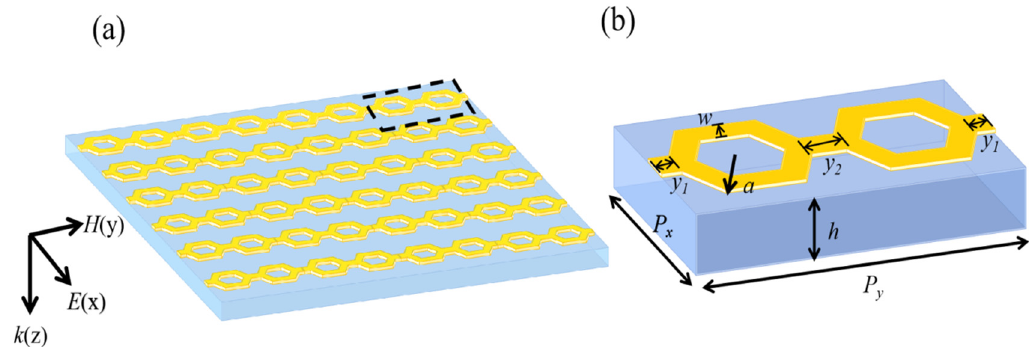
Figure 1. Schematic diagram of cascade hexagonal ring-shaped structure ( a ) Periodic arrangement chart; ( b ) Unit diagram.